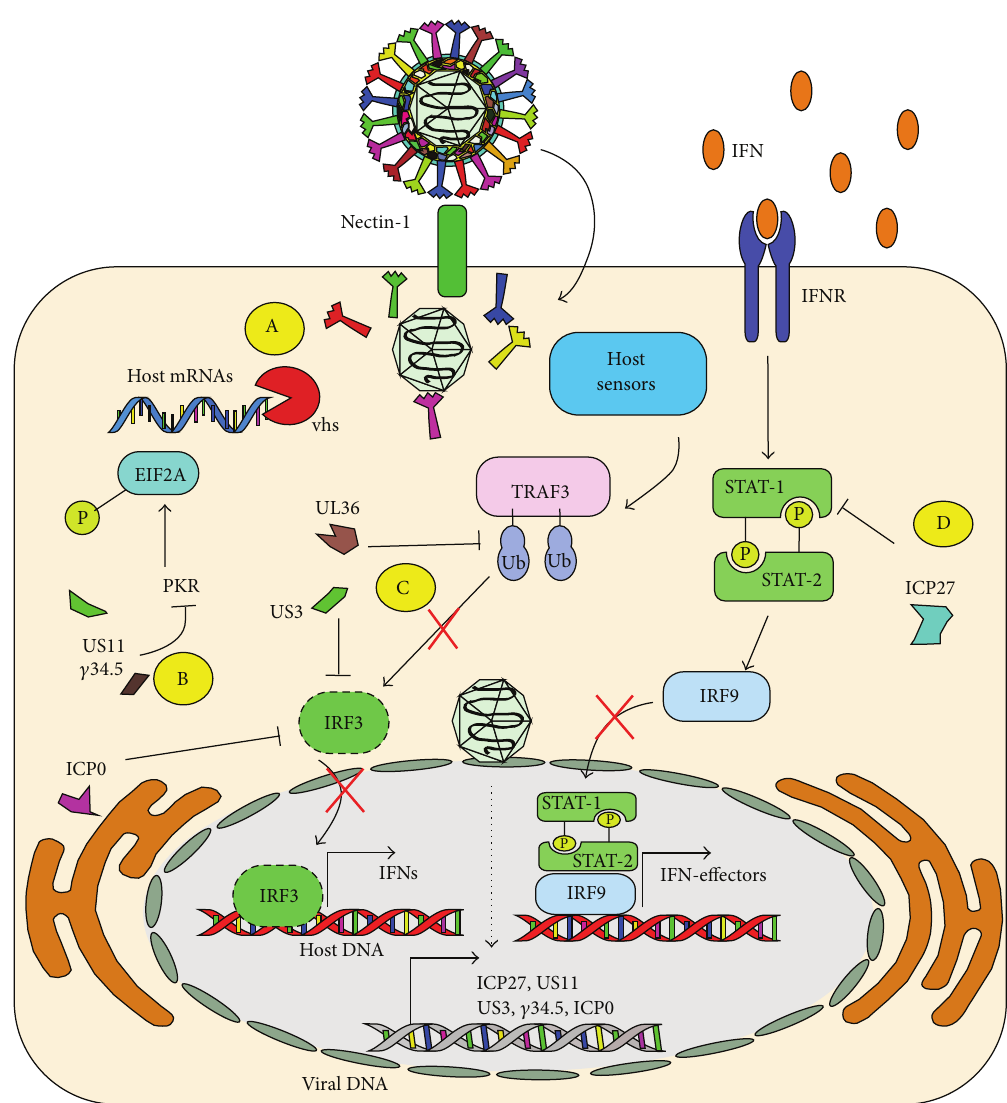
Figure 3: HSVs interfere with the induction of type-I interferons and interferon signaling. A: HSV vhs proteins interfere with cell protein translation by specifically degrading host mRNAs. B: Viral US11 and 𝛾 34.5 interfere with host PKR function, by impairing its capacity to phosphorylate EIF2A, which blocks translation within infected cells. C: Host sensors activate TRAF3 after detecting HSV determinants, which normally leads to IRF3 activation. However, UL36 interferes with TRAF3 ubiquitination blocking its IRF3-activating capacity. ICP0 and US3 also interfere with IRF3 activation. Impaired IRF3 function will result in poor secretion of interferons by infected cells. D: Viral ICP27 interferes with STAT-1 signaling mediated by IFNR, which would otherwise lead to the secretion of antiviral